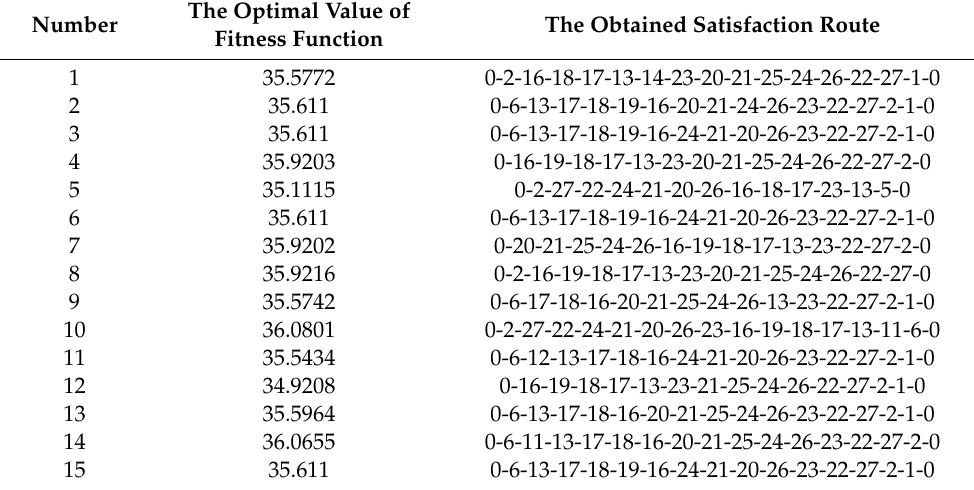
Table 5. The results of 15 tests using the PGA (28